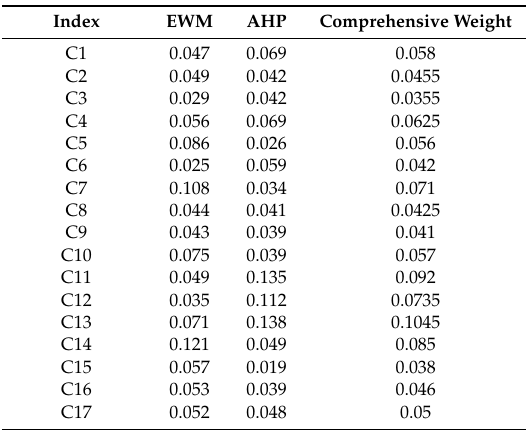
Table 2. Analytic hierarchy process (AHP) weight, entropy weight, and comprehensive weight of each